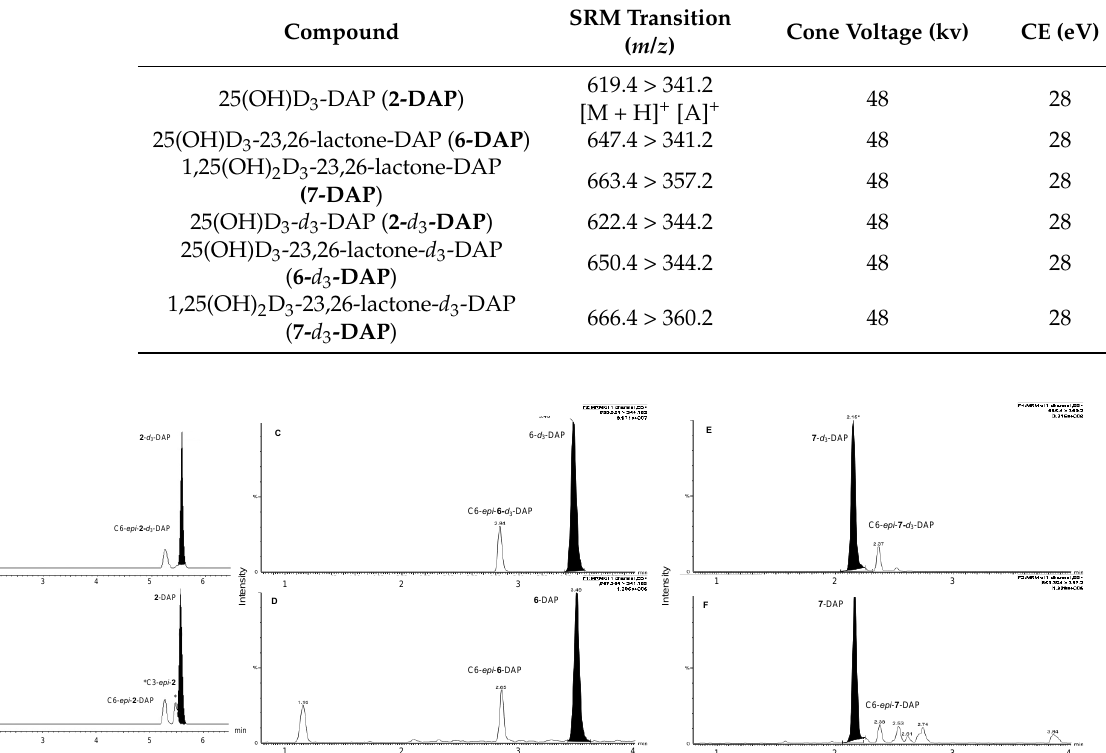
Table 1. Parameters for the LC/MS/MS analysis.